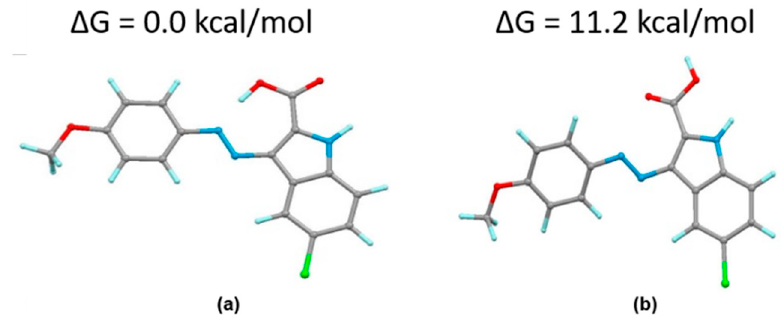
Figure A1. Gaussian calculation of two configurations of MTI163. The structure forming a 7-membered ring via an intramolecular hydrogen bond ( a ) is approximately 11 kcal / mol more stable than a conformation without such an intramolecular H-bond ( b ).